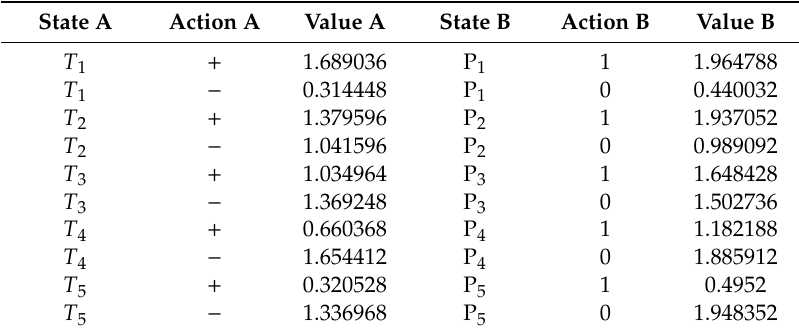
Table 16. Q Function table of the third